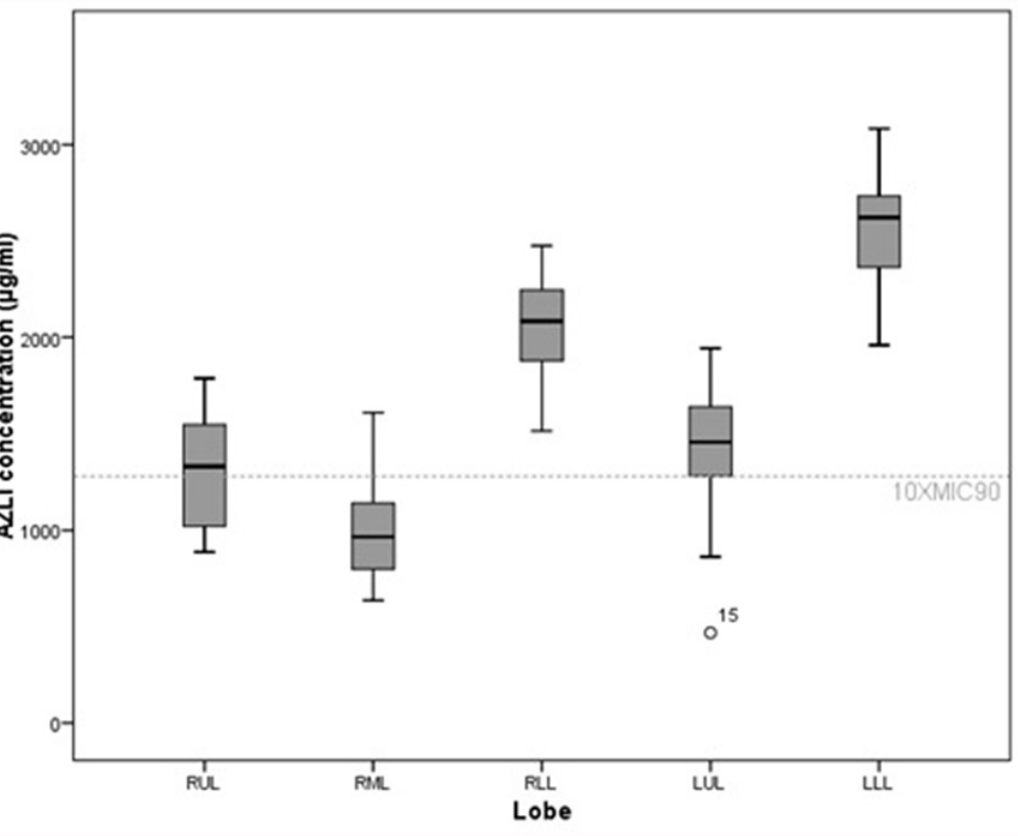
Fig 3. Differences between lobes in AZLI concentrations. Differences between lobes in AZLI concentrations for the scenario of thick airway surface liquid with largest aerosol diameter. Data are presented as median (range), unless otherwise indicated. Significant differences in AZLI concentrations were found between all lobes, except for one pairwise comparison (see S1 Table). RUL = right upper lobe, RML = right middle lobe. RLL = right lower lobe, LUL = left upper lobe, LLL = left lower